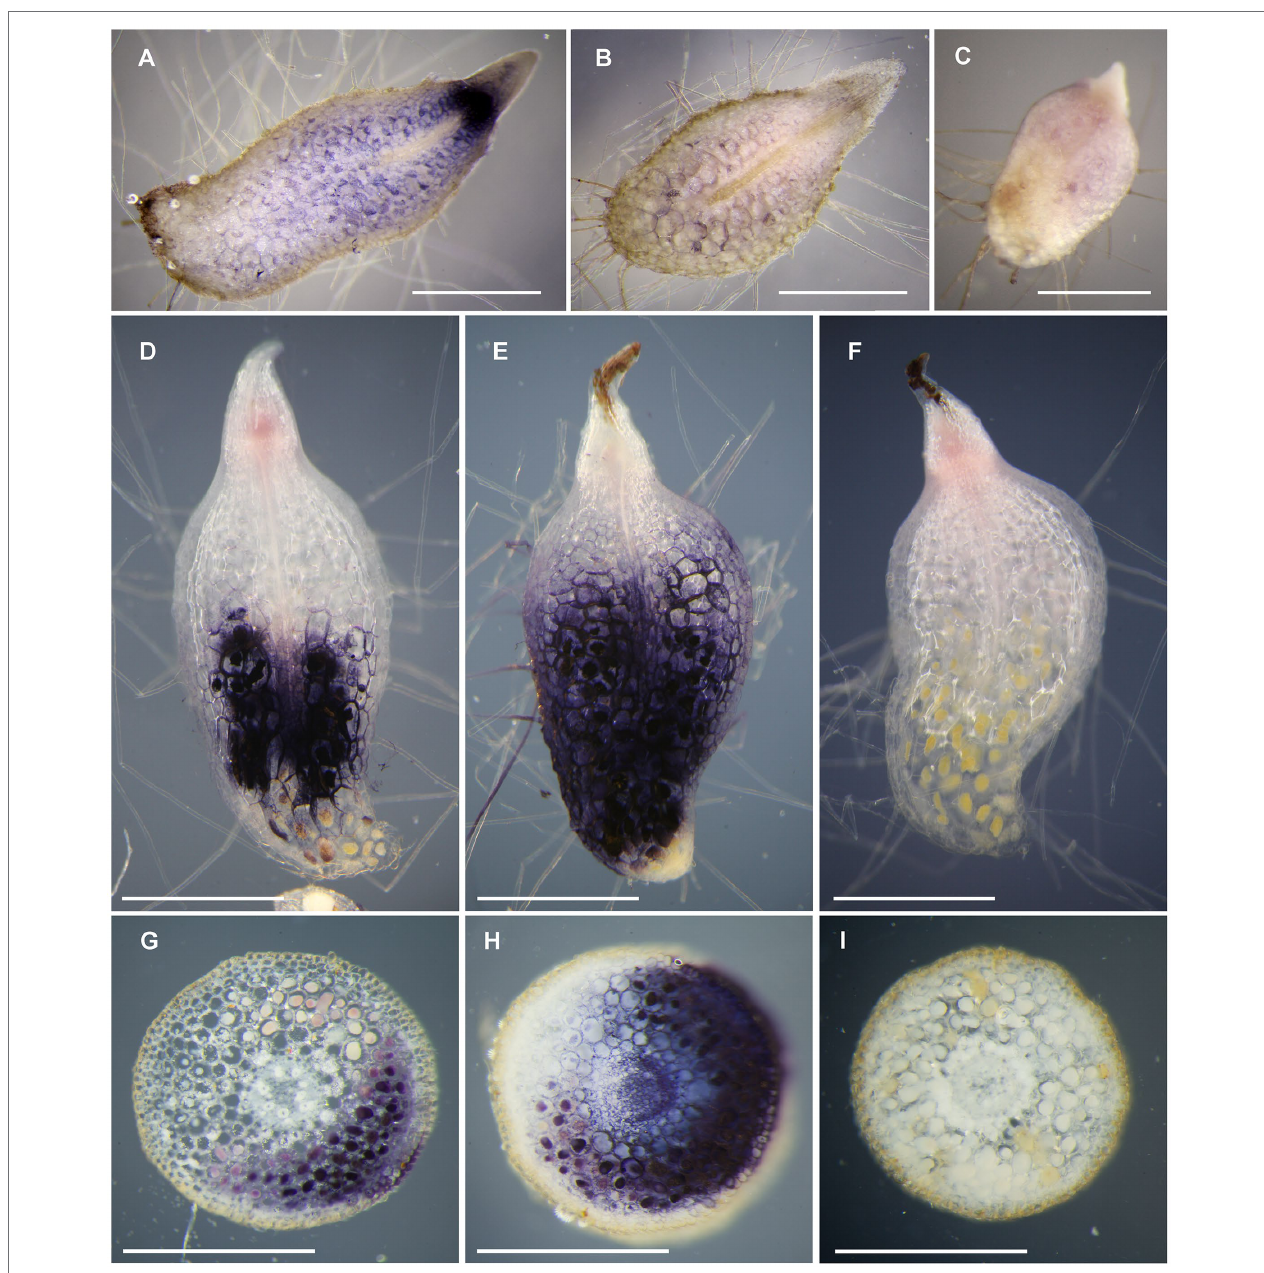
FIGURE 3 | Histochemical detection of trehalase activity in D. majalis tissues. Blue colored formazan precipitate marks trehalase activity. Control incubations without added substrate did not stain (C,F,I) . (A,C) Longitudinal sections of trehalose-supported asymbiotic protocorms, (B) glucose-supported asymbiotic protocorm, and (D-F) symbiotic protocorms cultured with Ceratobasidium sp. (G-I) cross sections of mycorrhizal roots of mature plants. The trehalase activity is present in the vicinity of pelotons (D,E,G,H) . Scale bars 1